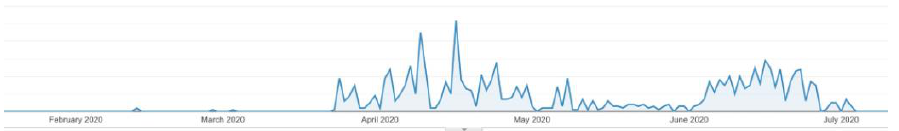
Fig. 7e. Dynamics of visits to the Definition of improper integral of the second kind (from unlimited